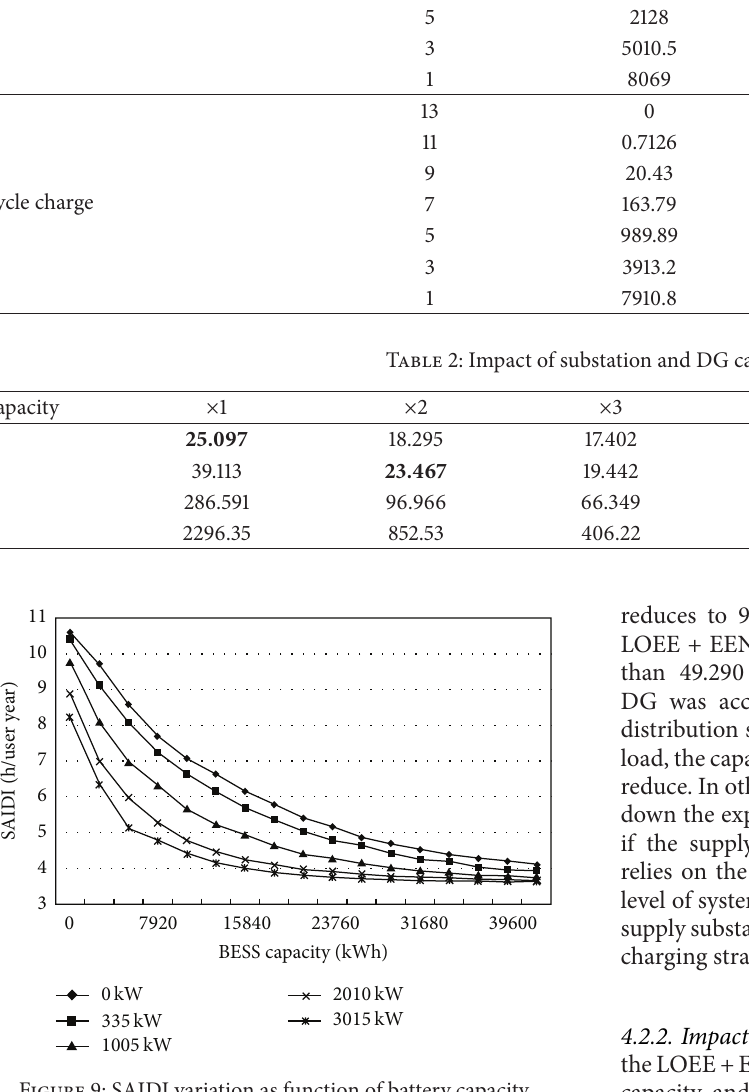
Figure 9: SAIDI variation as function of battery